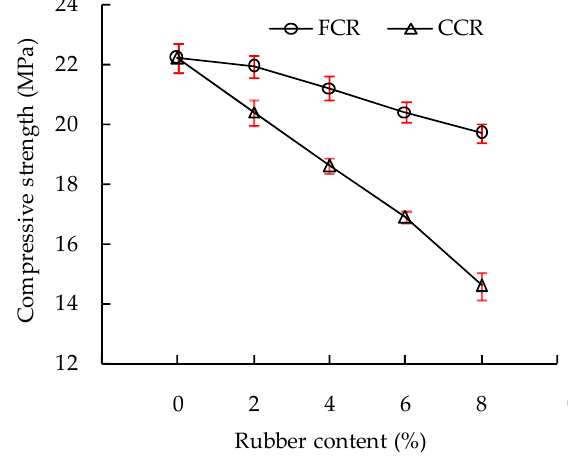
Figure 6. Compressive strength of RMPC versus rubber content.